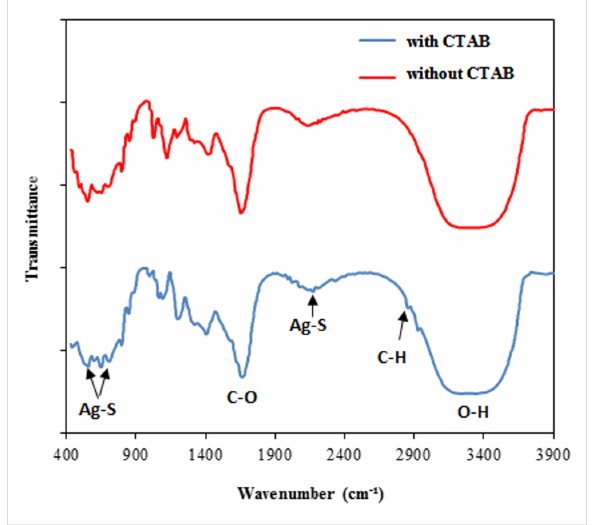
Figure 7: FTIR spectra of Ag2S NPs prepared without and with CTAB.